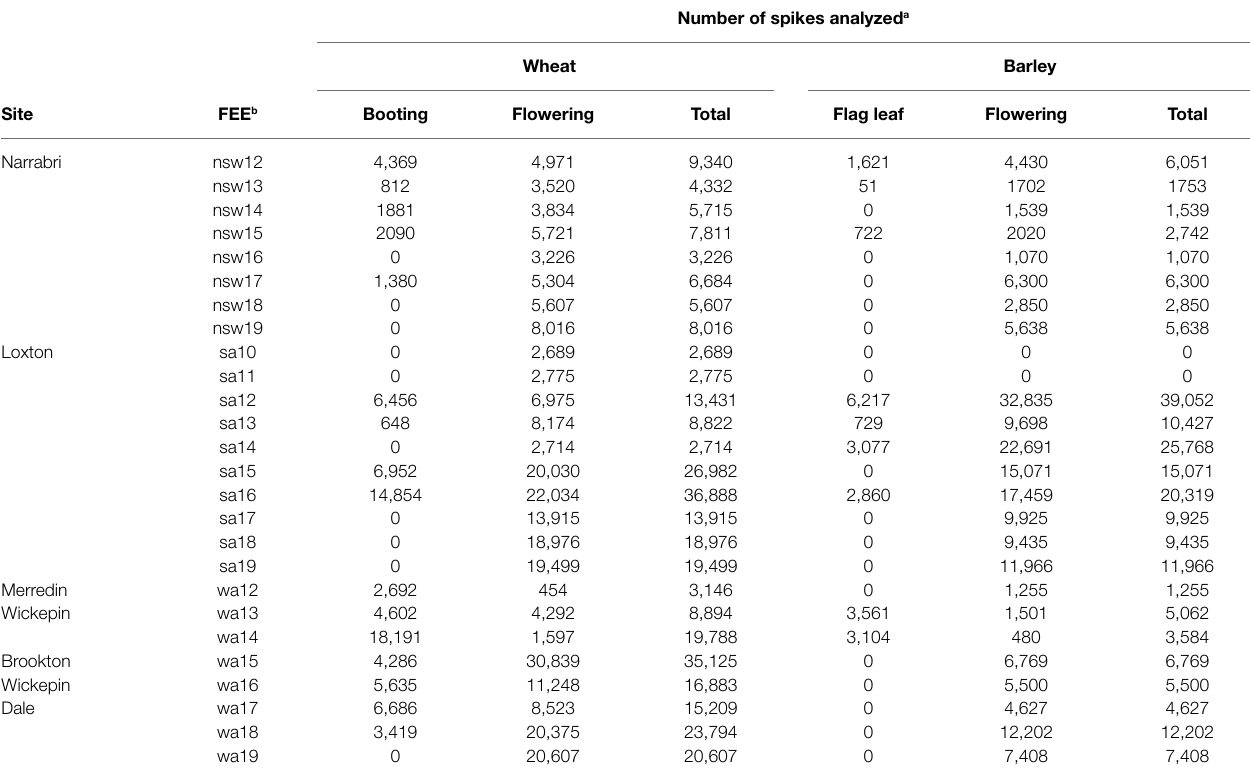
TABLE 3 | Number of spikes analyzed by crop across FEEs at different developmental stages following Zadoks scale (Zadoks et al., 1974). Number of spikes analyzed a Wheat